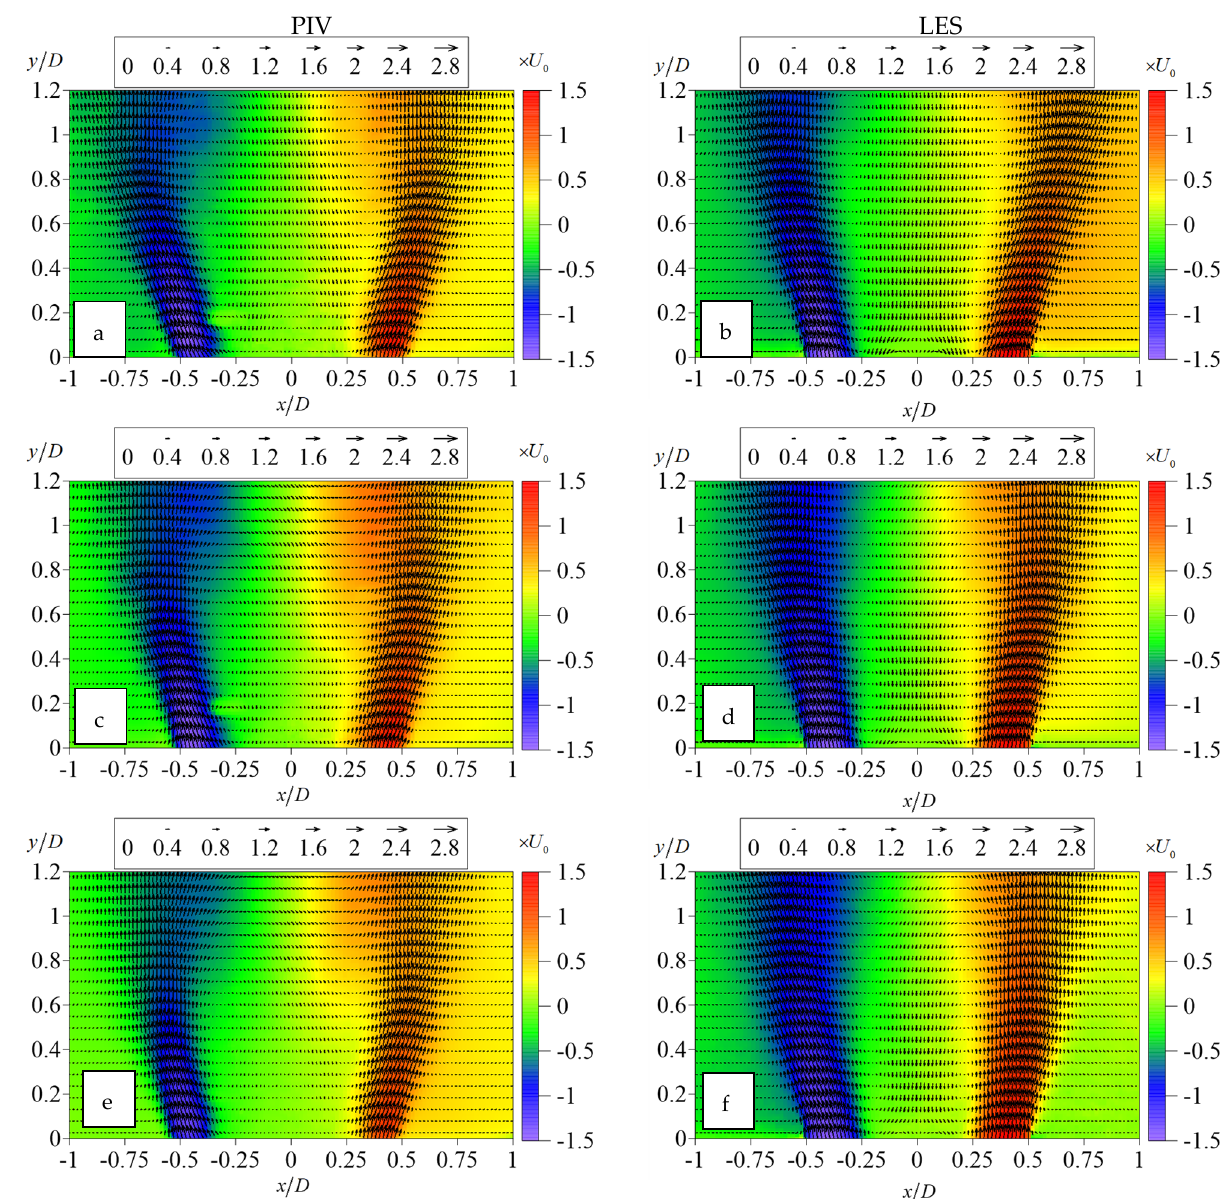
Figure 2. Experimental data and numerical simulation of the mean flow field for methane–air flames at different pressure conditions: ( a , b )—1 atm. 293 K; ( c , d )—2 atm. 500 K; ( e , f )—3.4 atm. 500 K.